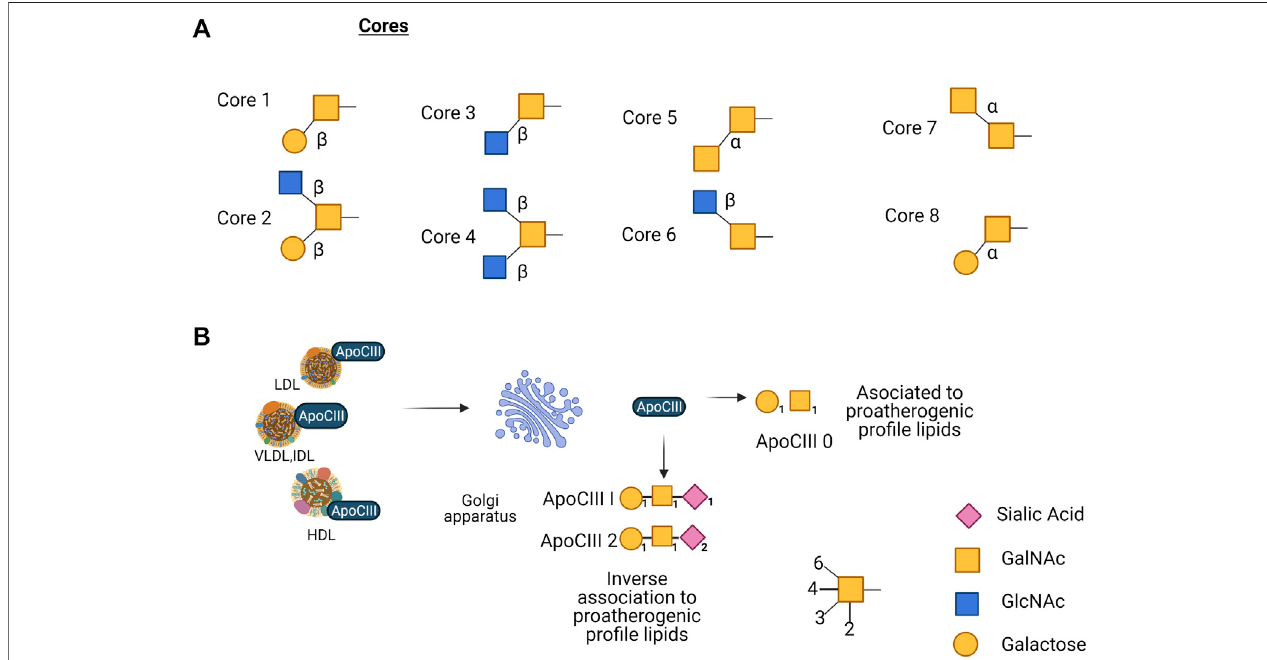
FIGURE 2 | (A) Core structures reported of mucin-type O -glycans, eight in total, only cores 1 – 4 show widespread abundance, core structures 5 – 8 have a highly restricted occurrence, and core 7 has not been found in humans. (B) ApoC-III present in LDL, VLDL, and HDL is glycosylated in the Golgi apparatus, apoCIII 0 (non- sialylated)isassociatedwithproatherogenicpro fi lelipids;apoCIII 1 (mono-sialylated)andapoCIII 2 (di-sialylated)areinverselyassociatedwithproatherogenicpro fi